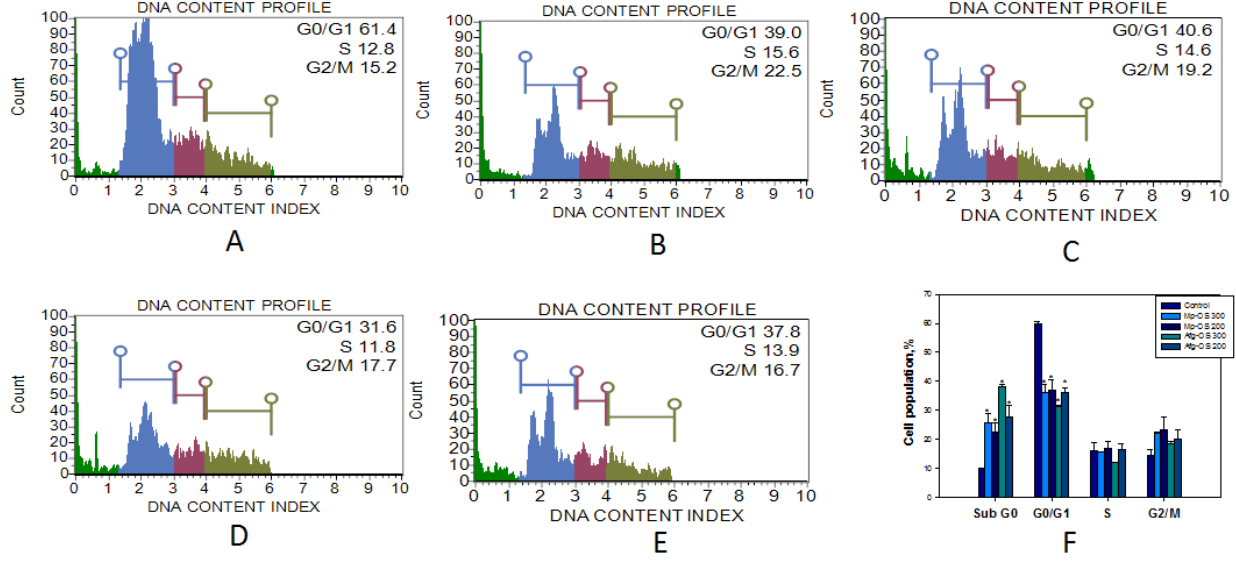
Figure 6. Histograms of the distribution of HCT-116 cells by phases in the control ( A ). Effect of Mp-OS (( B )-300 μg/mL, ( C )-200 μg/mL) and Afg-OS ( D )-300 μg/mL, ( E )-200 μg/mL) on the distribution of HCT-116 cells by cell cycle phases. Graph of cell distribution by cell cycle phases ( F ). The time of incubation of oligosaccharides with cells is 72 h. Data are presented as means ± SEM. * p value < 0.05 considered significant.